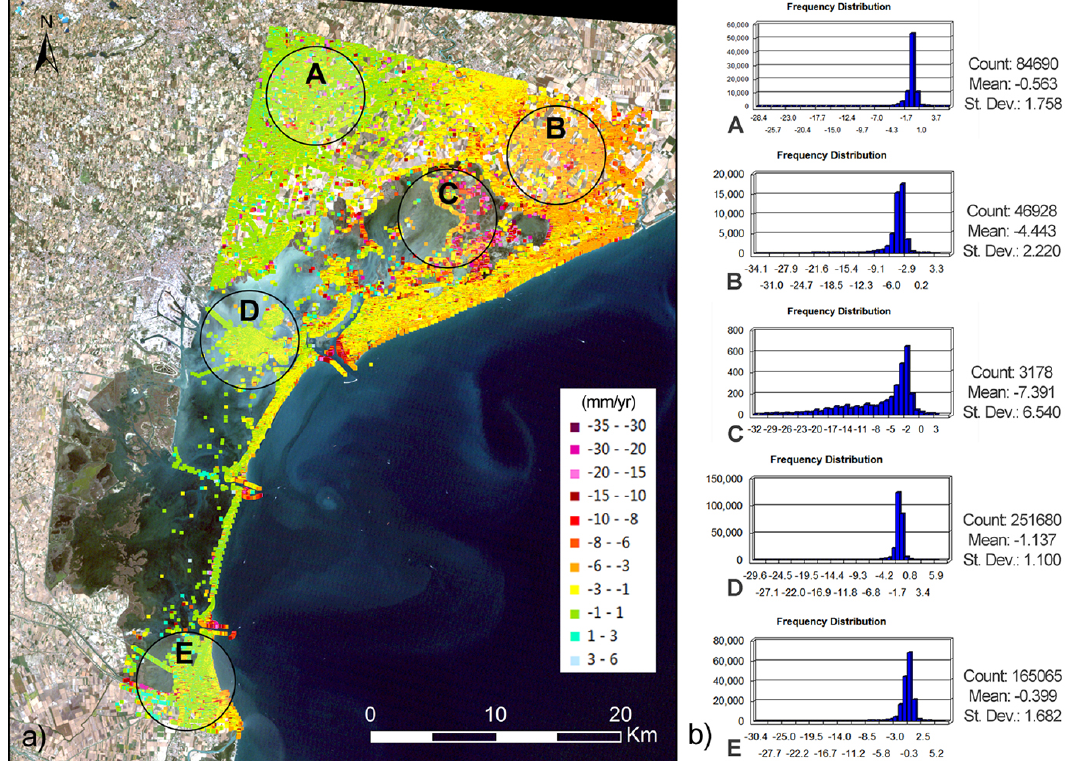
Figure 2. (a) Average land displacements (mmyr − 1 ) for the Venice coastland obtained by PSI on TerraSAR-X images acquired between March 2008 and August 2011. Positive values mean uplift, negative values land subsidence. A Landsat image obtained from the US Geolog- ical Survey – Earth Resources Observation and Science (EROS) Center is used as base map. (b) Frequency distribution of the displacement rates for the PS located in the A-E circular areas ( r = 3km) highlighted on the map.